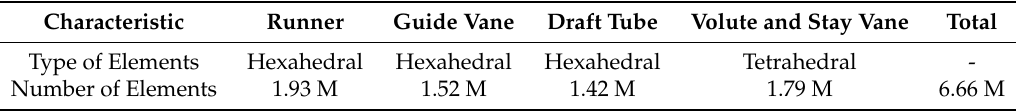
Table 2. Mesh specifications of the